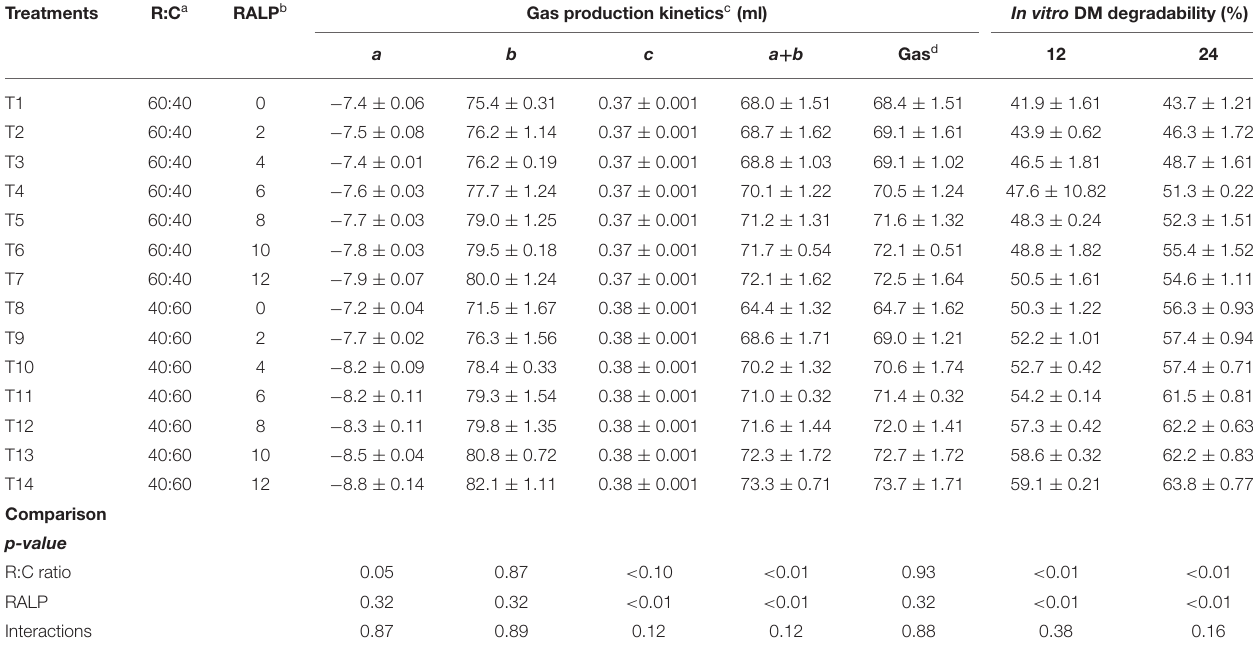
TABLE 2 | Effect of RALP supplementation on gas production and in vitro DM degradability.